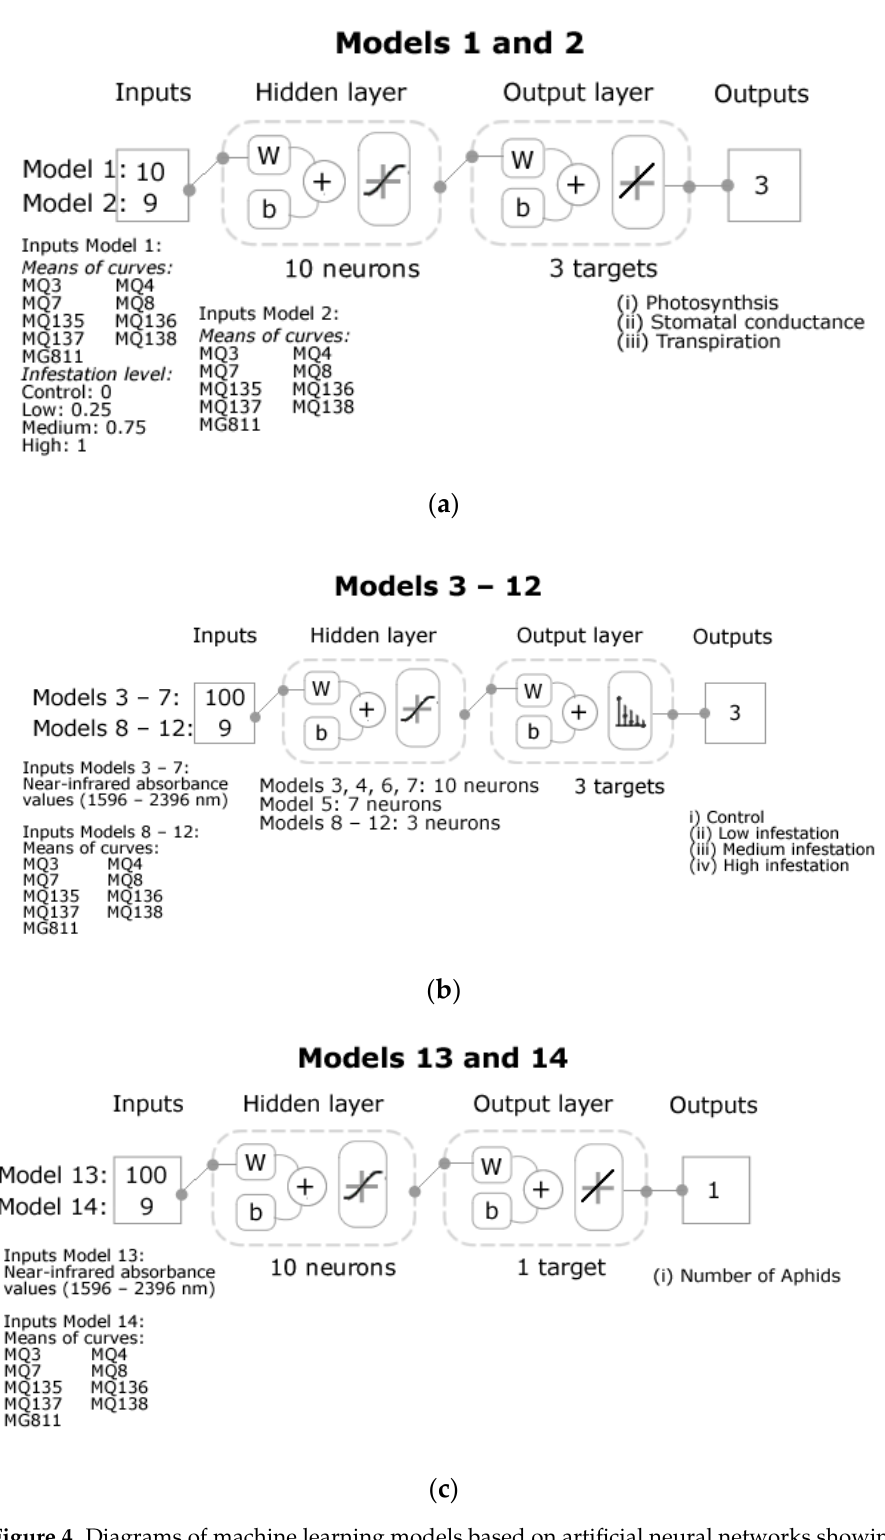
Figure 4. Diagrams of machine learning models based on artificial neural networks showing ( a ) the structure of regression Models 1 and 2; ( b ) Pattern recognition Models 3 to 12, and ( c ) Regression Models 13 and 14. Abbreviations: W: weights; b: bias; electronic nose sensors MQ3: alcohol; MQ4: methane; MQ7: carbon monoxide; MQ8: hydrogen; MQ135: ammonia/alcohol/benzene; MQ136: hydrogen sulfide; MQ137: ammonia; MQ138: benzene/alcohol/ammonia; MG811: carbon dioxide.